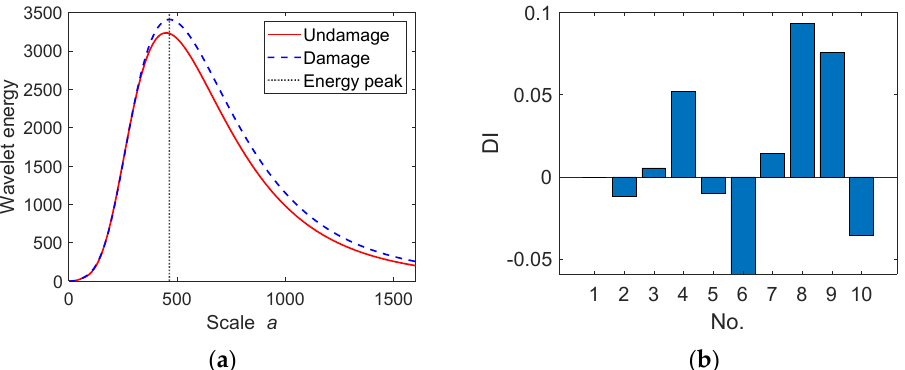
Figure 14. Bridge damage identification at higher velocity. ( a ) wavelet energy; ( b ) damage index.